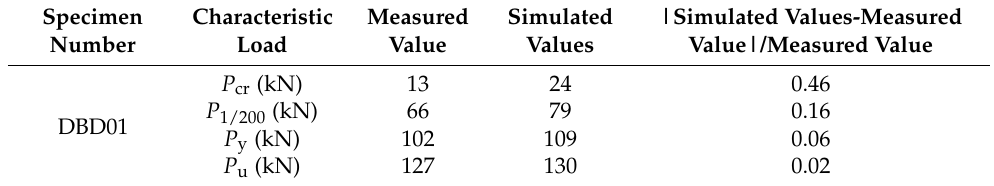
Table 6. Comparison between simulated and measured values of specimen bearing capacity. Specimen